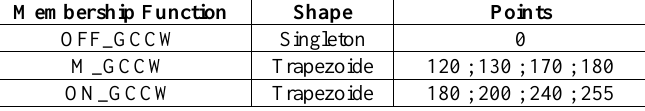
Table 9: Functions member of the Polar motion motor.